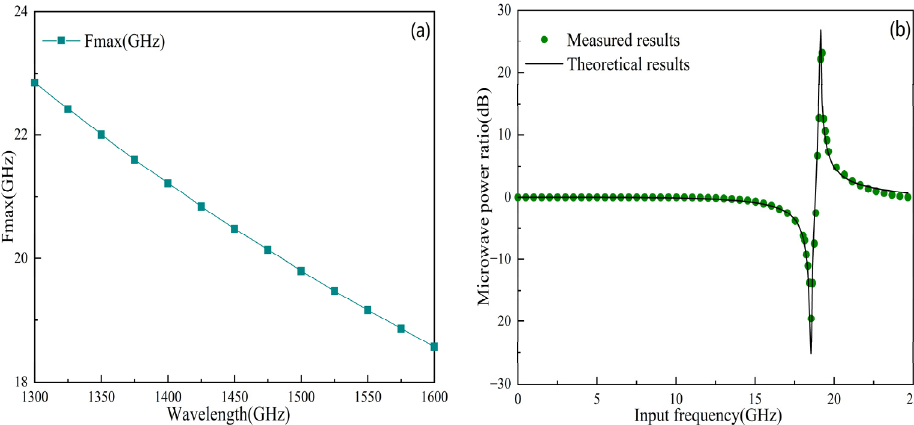
Figure 4. ( a ) The relationship between the maximum measured frequency value and wavelength. ( b ) The microwave power ratio of the measured and theoretical results.